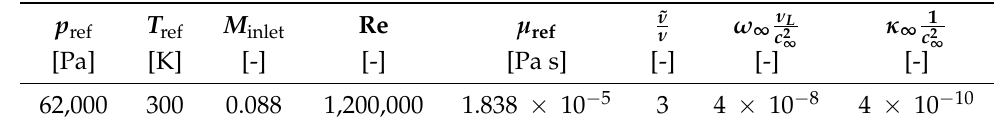
Table 4. Input parameters for Nakayama airfoil.